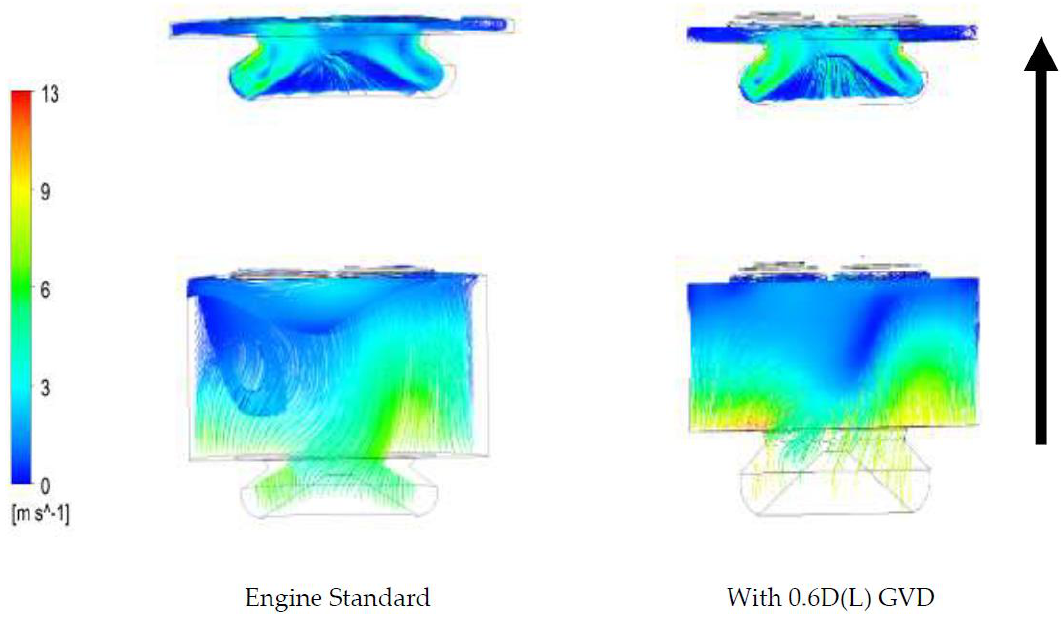
Figure 13. The in-cylinder process of compression stroke CA at 350° (top) and 310° (bottom).